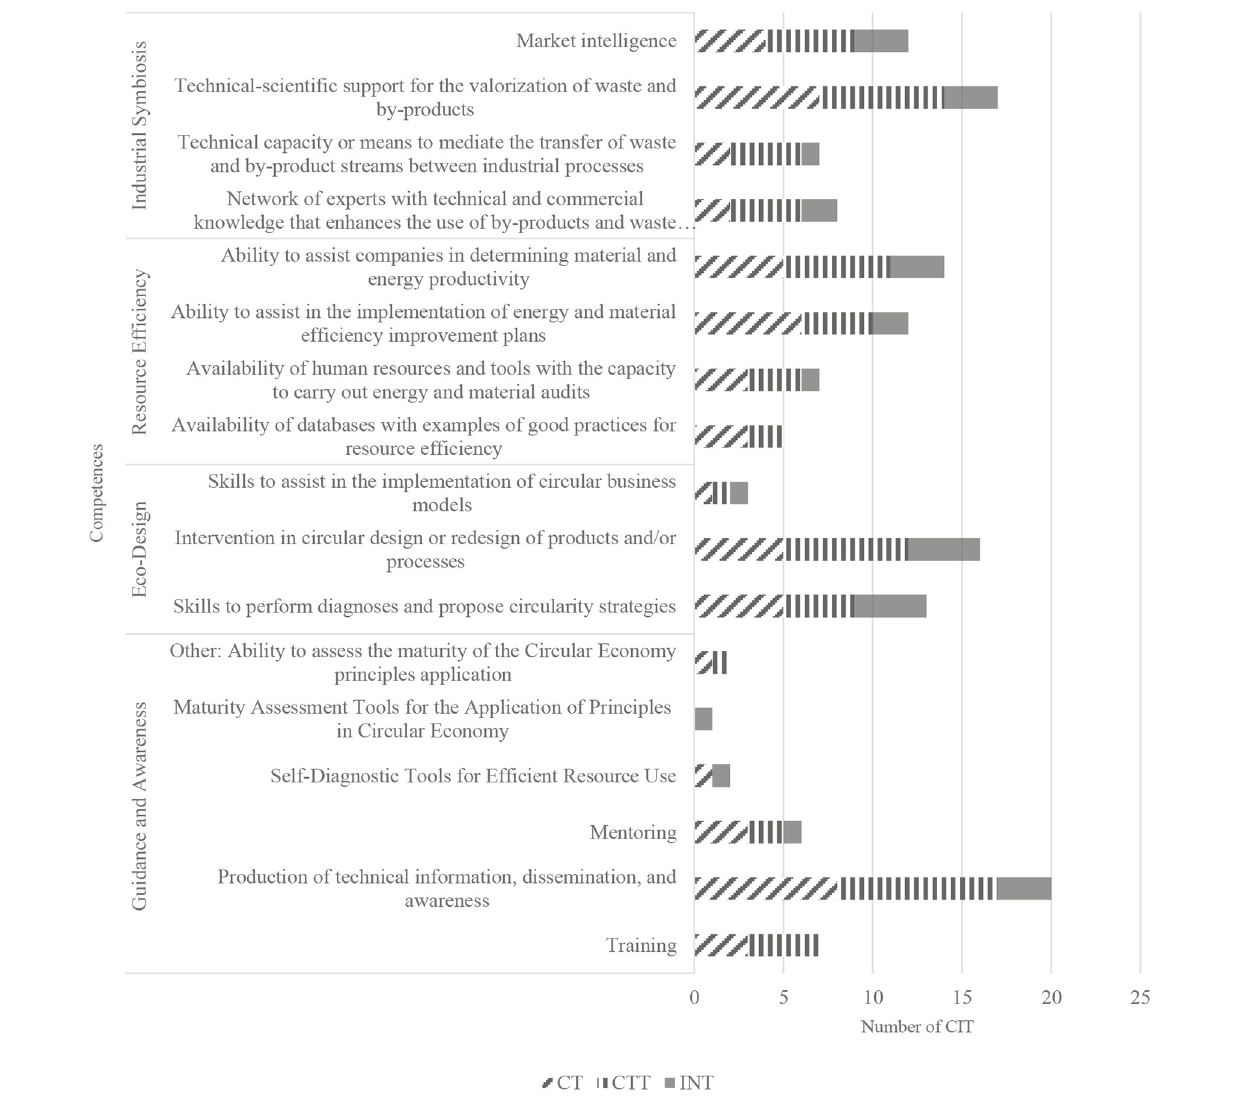
FIGURE 3 | Weight of competences in each